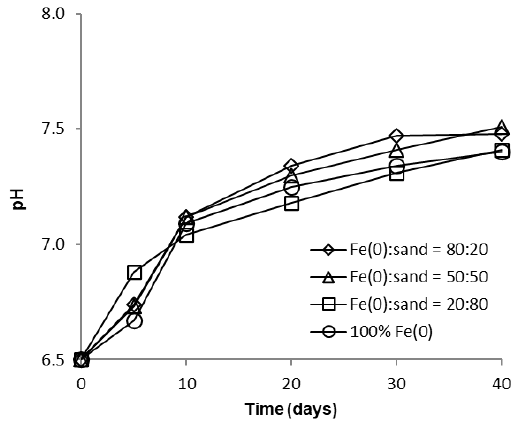
Figure 7 . Evolution of pH in batch experiments at high Cr VI initial concentration .